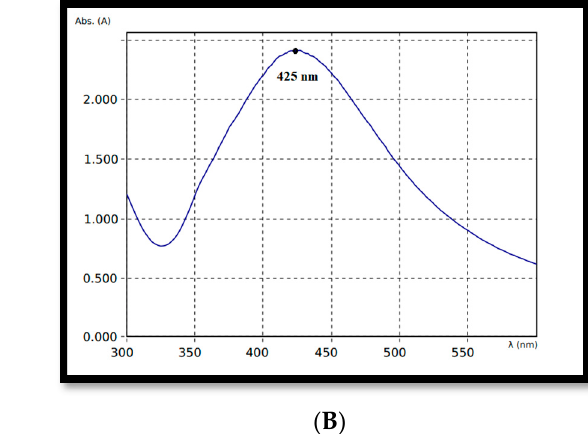
Figure 2. ( A ) UV visible spectroscopic image of Azadirachta indica -based silver nanoparticles. ( B ) UV visible spectroscopic image of Pongamia pinnata -based silver nanoparticles.